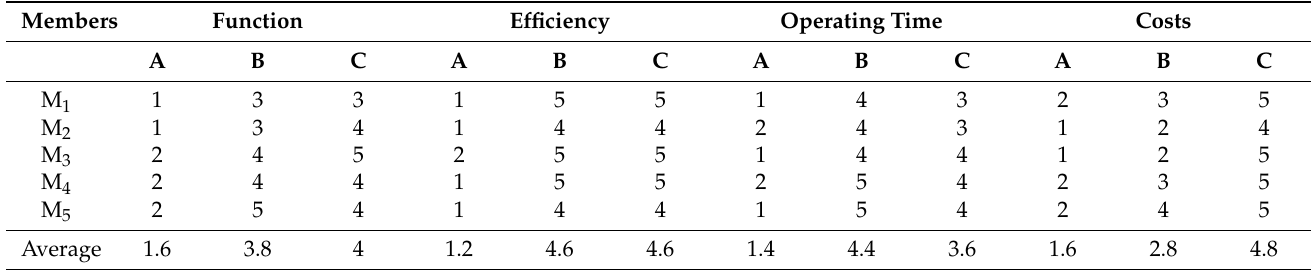
Table 4. Ideality of design solution.